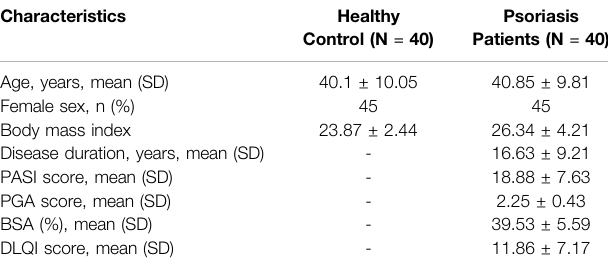
TABLE 1 | Details of moderate-to-severe plaque psoriasis patients.